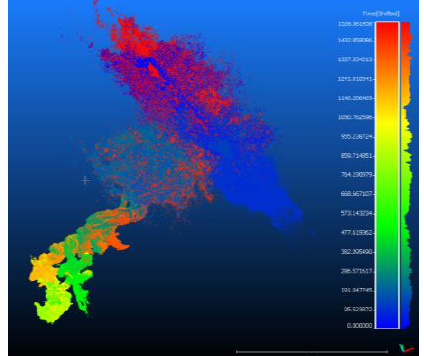
Figure 14. The colour ramp show the time sequence of cloud collection, and it is quite readable the low density of outdoor cloud portion, and very high density of indoor cloud (due to the slowness of on all fours moving forward).